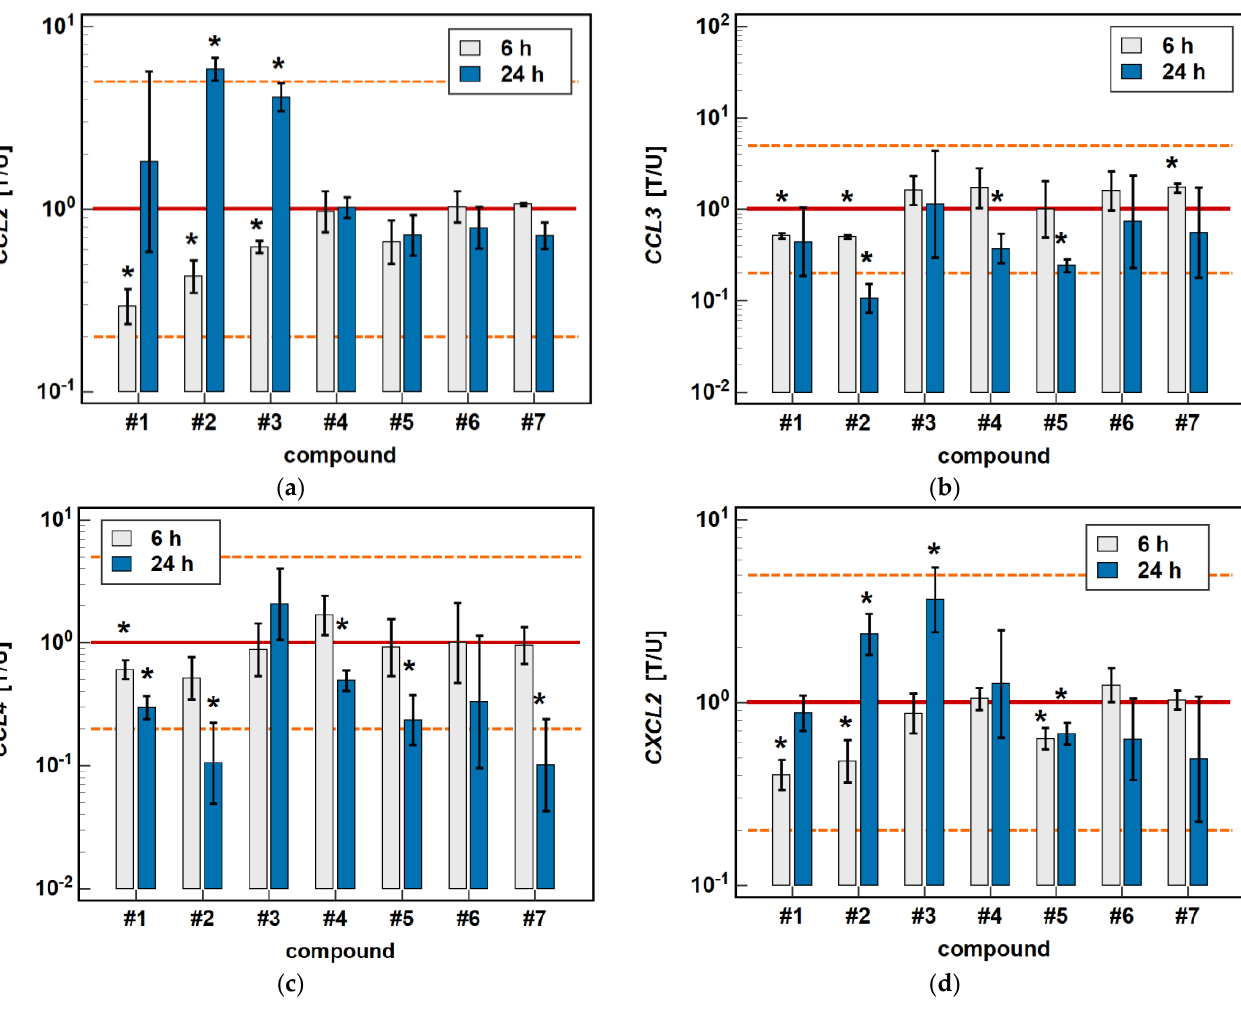
Figure 3. Time-dependent effect of oxicams on MCP and MIP expression in Caco-2 cells: ( a ) CCL2 ; ( b ) CCL3 ; ( c ) CCL4 ; ( d ) CXCL2 . The bars and whiskers represent the mean ± SD expression ratio of the normalized relative quantities [NRQ] obtained for cells treated with 200 μM oxicams for 6 and 24 h, and the corresponding untreated controls [T/U]. The significant differences between the treated and untreated cells, analyzed using a t -test for paired samples, are indicated by asterisks (*). The expression ratio of 1 (no change) is indicated by a red solid reference line, while the expression ratio of 5 (5-fold upregulation) and the expression ratio of 0.2 (5-fold downregulation) are indicated by an orange dashed reference line. Compound # 6 denotes piroxicam, and # 7 denotes meloxicam.